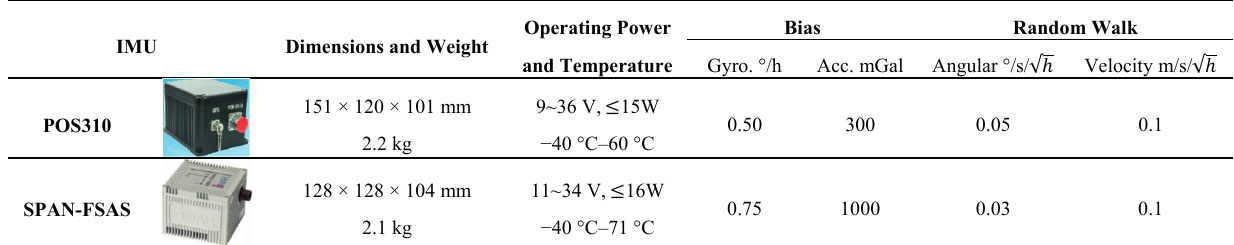
Figure 2. Trajectory of the airborne experiment ( a ) and the number of observed satellites and the PDOP ( b ) on 24 August 2014, in Guangzhou, China. Table 1. Technical Parameters of the POS310 and SPAN-FSAS